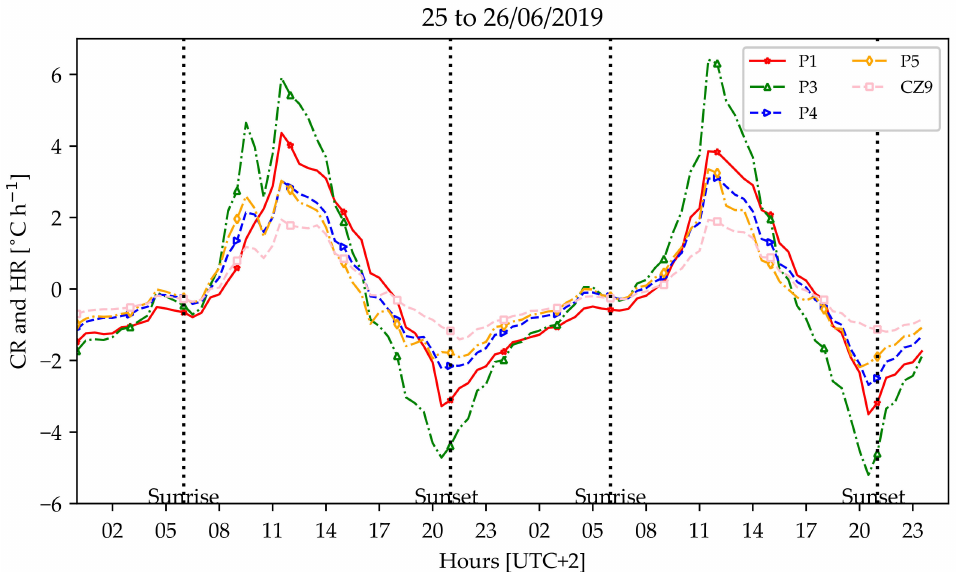
Figure 13. Representation of the rate of change (RC) ( ◦ C h − 1 ) in five PLTs at − 3 cm depth (25 to 26 June 2019). P1 is represented with a red solid line with star markers. P3 is represented with a green dotted line with triangle up markers. P4 is represented with a blue dotted line with triangle right markers. P5 is represented with an orange dotted line with diamond markers. CZ9 is represented with a pink dashed line with square